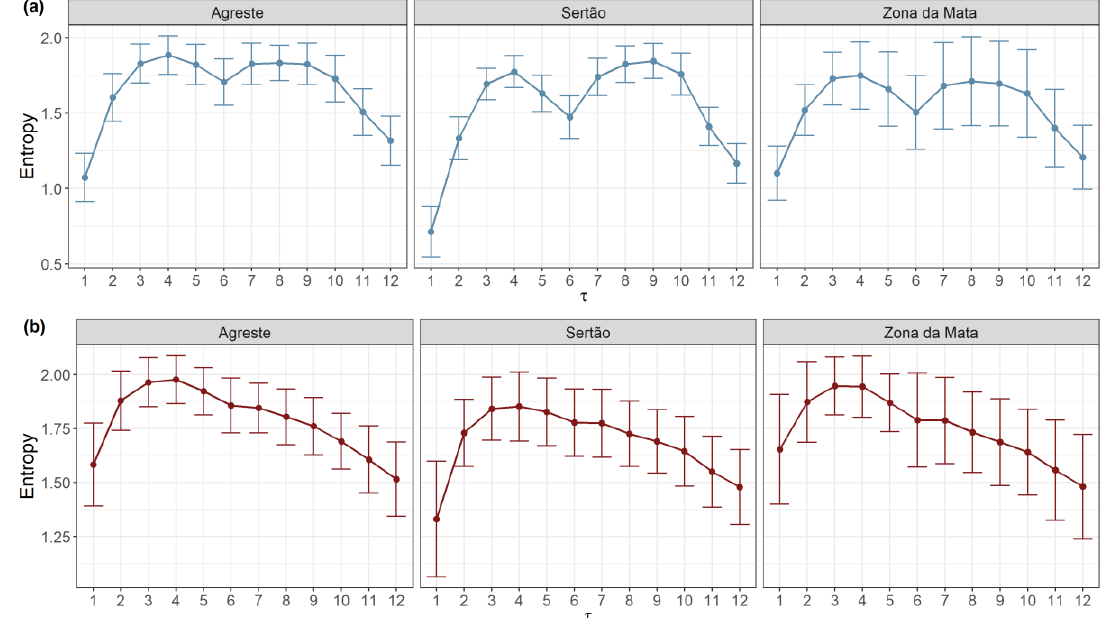
Figure 7. Average MMSE (together with standard deviation) for ( a ) monthly rainfall and ( b ) monthly anomalies for Zona de Mata, Agreste and Sertão.